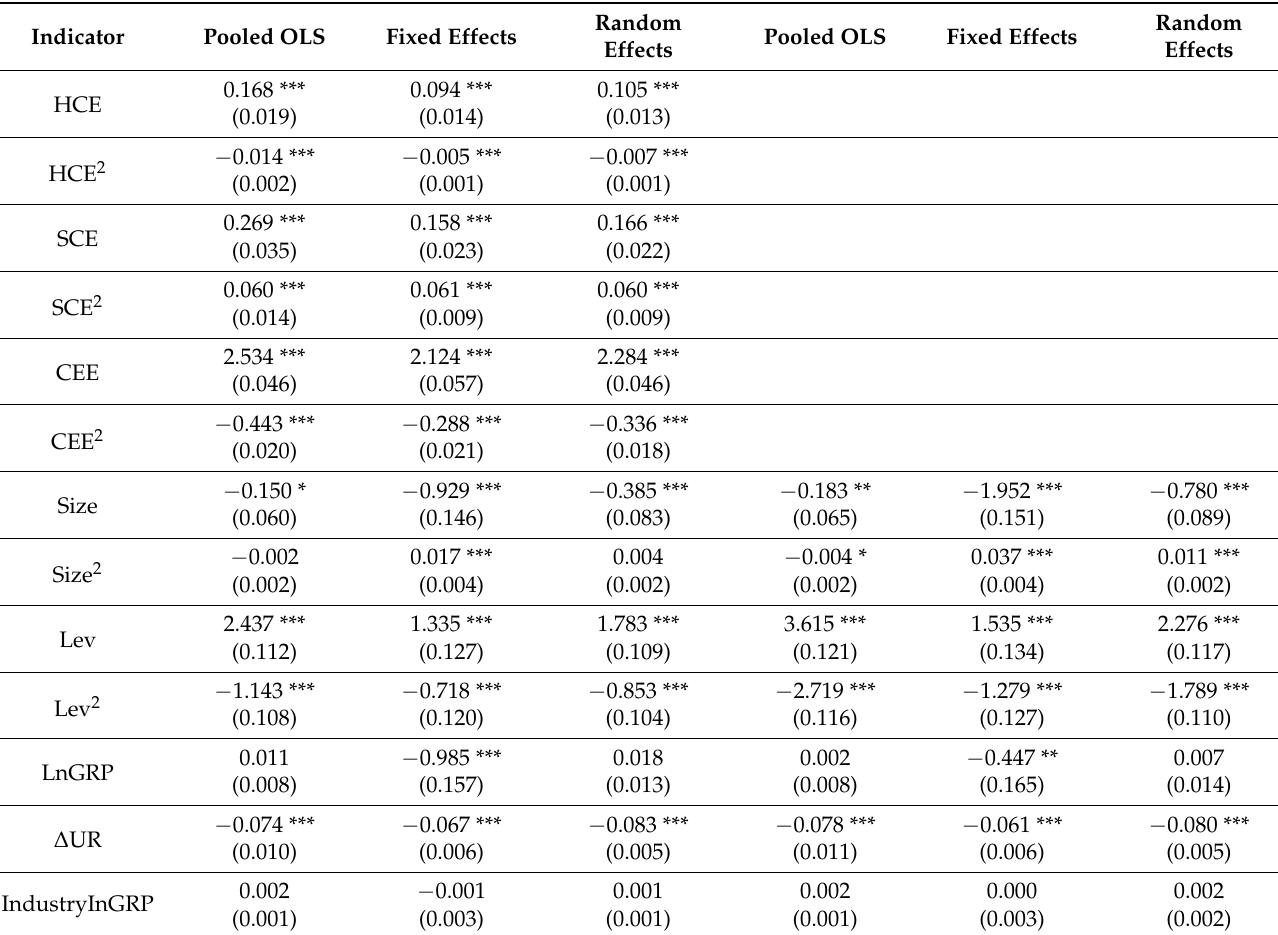
Table 4. Results of regression analysis for models with ATO as the dependent